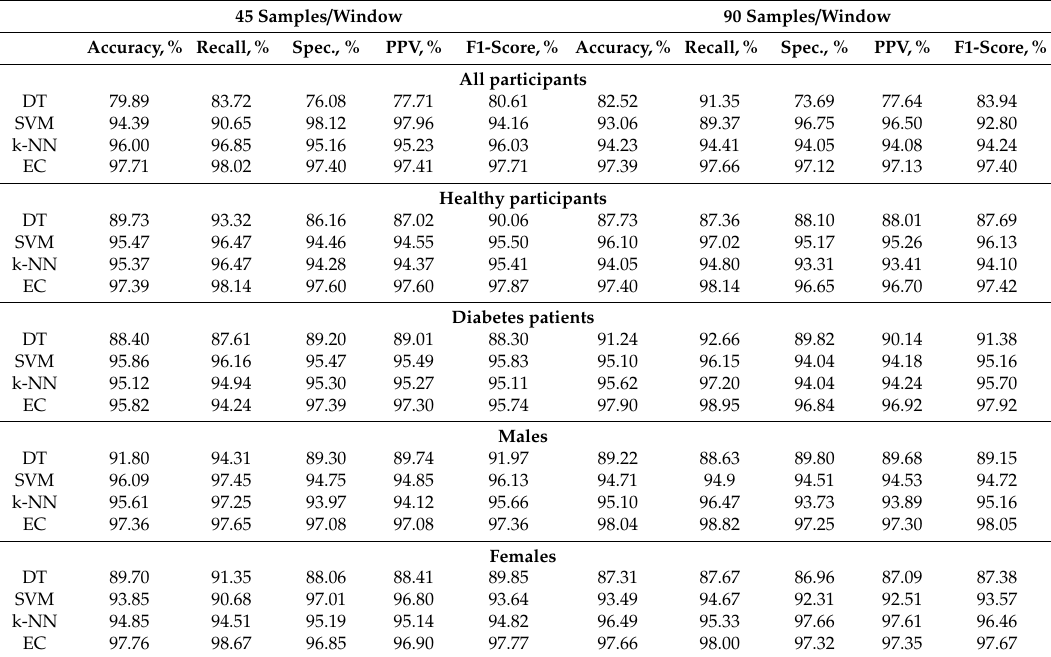
Table 3. Evaluation metrics of the classifiers’ performance. 45 Samples / Window